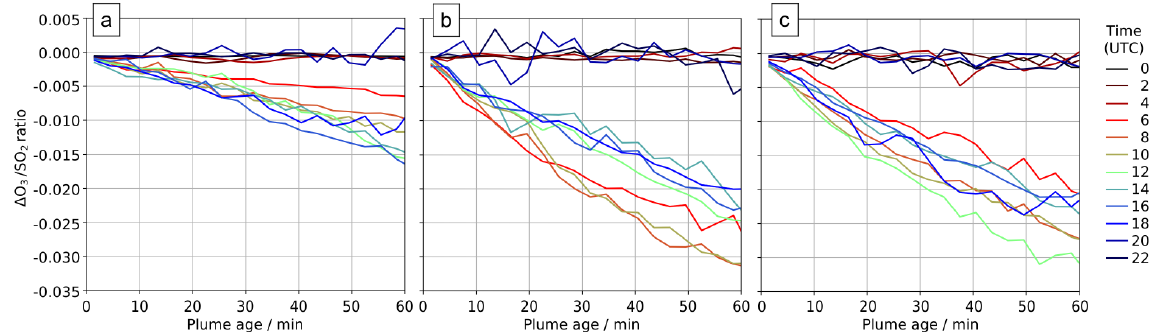
Figure 15. In-plume average (cid:49) O 3 / SO 2 ratios for plumes of different ages ranging from 0–60min at several times on (a) 30 July 2012, (b) 31 July 2012, and (c) 1 August 2012. Only ratios where the corresponding SO 2 column exceeds 2 . 0 × 10 16 molec.cm − 2 are